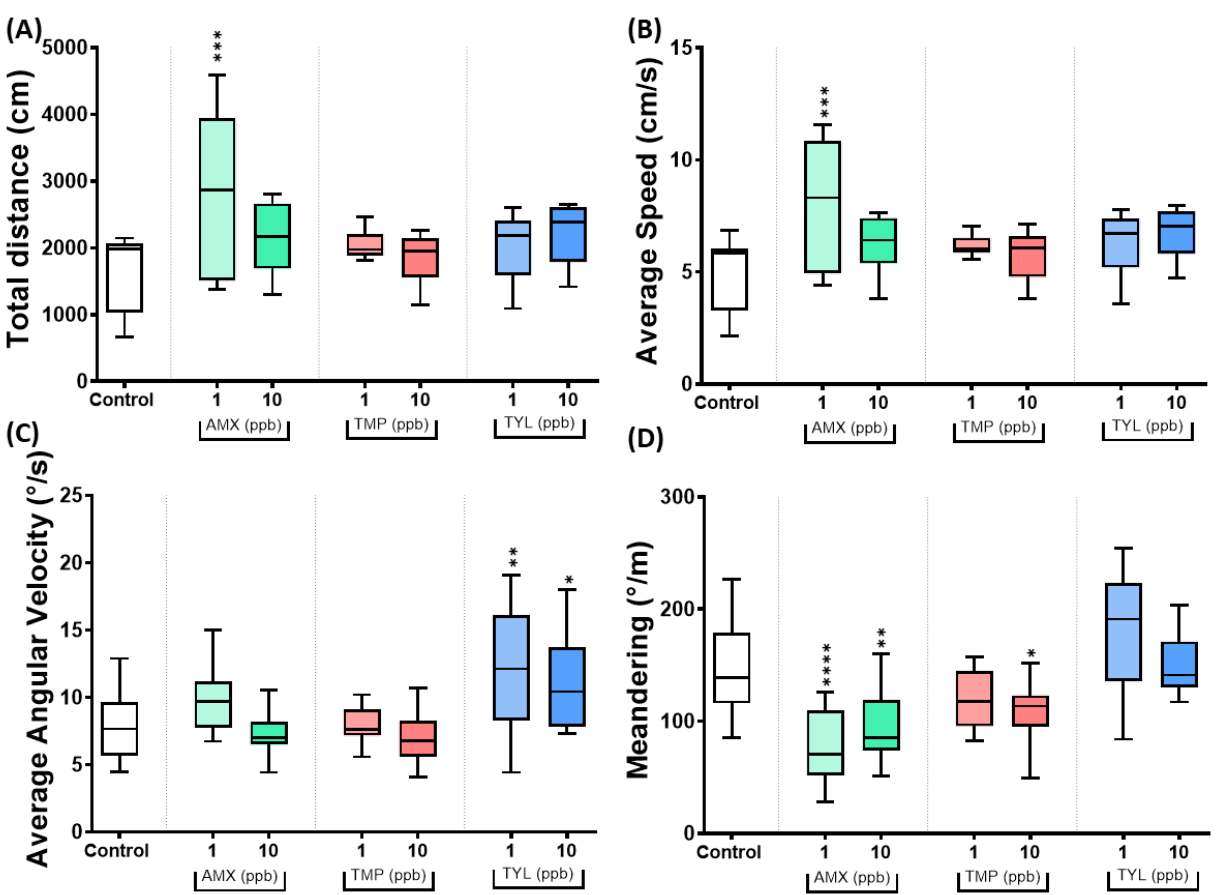
Figure 6. The locomotor activity endpoints of control and antibiotic-treated golden zebrafish after 10 days exposure. ( A ) Total distance traveled (cm); ( B ) average speed (cm/s); ( C ) average angular velocity (°/s); and ( D ) meandering movement (°/m). The data are expressed as mean ± S.E.M and were analyzed by ordinary one-way ANOVA followed by Dunnett’s test ( n control: 12, n for antibiotic groups: 12, except n for AMX 1 ppb and TMP 10 ppb: 11, and n TYL 10 ppb: 10). The significances were indicated by * p < 0.05; ** p < 0.01, *** p < 0.001, and **** p < 0.0001 when compared to control group.